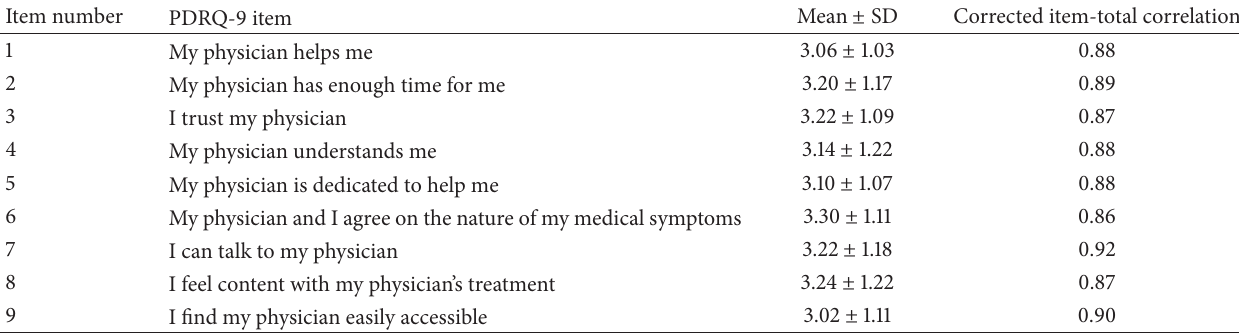
Table 1: Distribution of item characteristics of PDRQ-9 Bangla ( 𝑁 = 50 ).